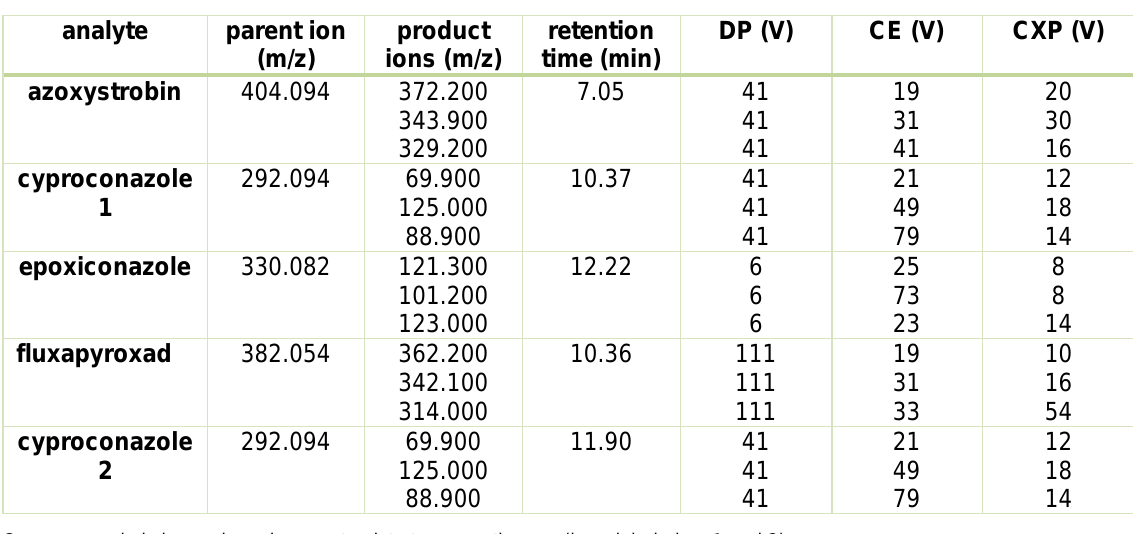
Figure 1: Cytotoxic ef- fects of Adexar ® (red); its active substances mix (epoxiconazole and fluxapyroxad (green)); and a co-formulant of Adexar® (blue) on Hep- aRG cells after 24 h treatment obtained from NRU assay. Concentra- tion data were trans- formed using X=log(X) and then normalized to the solvent control. Er-